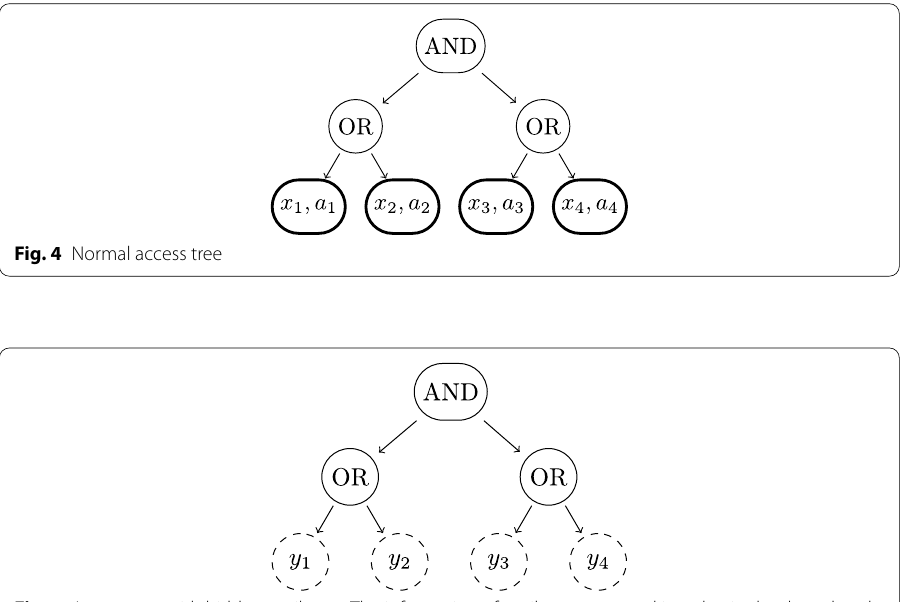
Fig. 5 Access tree with hidden attributes. The information of attribute name and its value in the dotted node is fully hidden, only the index of the node is